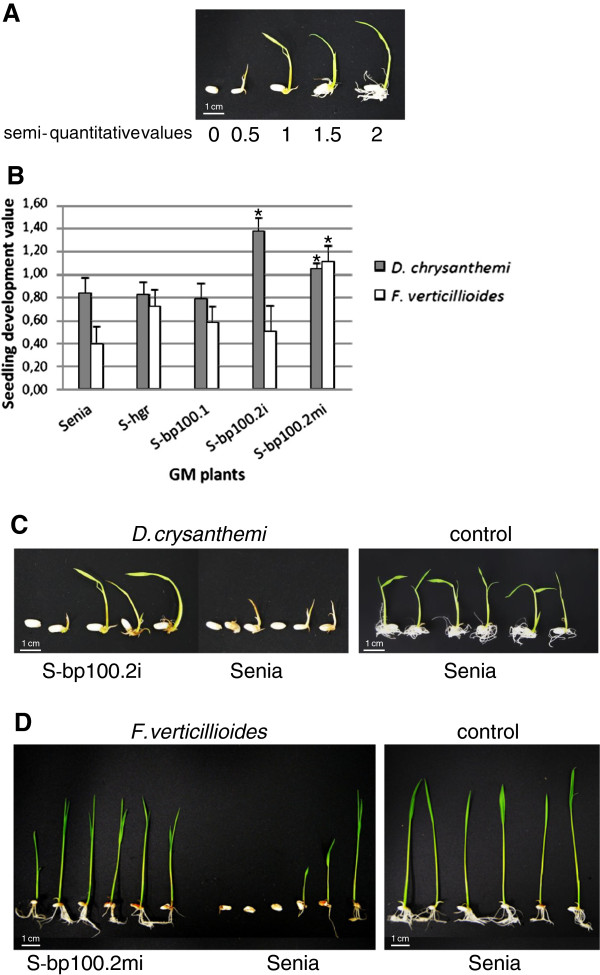
Susceptibility to Dickeya chrysanthemi (D. chrysanthemi) and Fusarium verticillioides (F.verticillioides ) of control untransformed Senia and S-bp100.1, S-bp100.2i, S-bp100.2mi and S-hgr GM plants in a germination assay.(A) Representative examples of seedlings with different semi-quantitative development values to estimate D.chrysanthemi effects: 0, no germination; 0.5, cotyledon development; 1, standard shoot but no root development; 1.5, standard shoot development but short roots; and 2, standard growth. (B) Means and standard errors of seedling development values are represented as a function of the transgene in each line (every homozygous line obtained in this work was analyzed). Both for D. chrysanthemi and F. verticillioides susceptibility, a value of 0 indicated no germination while a value of 2 represented development similar to uninfected seeds. Asterisks indicate statistically significant differences compared to Senia (one-way ANOVA P values are given in the text). (C) Representative examples of S-bp100.2i (left) and Senia (center) seedlings grown in the presence of 105 CFU D. chrysanthemi. Germination of Senia control seeds (right). (D) Representative examples of S-bp100.2mi (left) and Senia (center) seedlings grown in the presence of 105CFU F. verticillioides and germination of Senia control seeds (right). Scale bars: 1 cm.